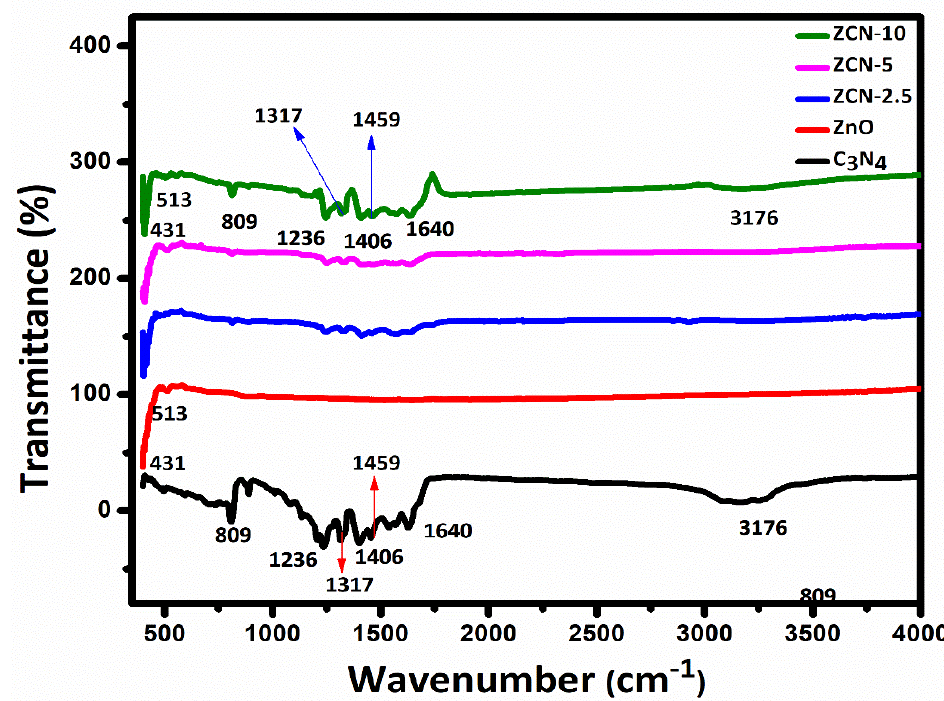
Figure 1. The FTIR spectra of ZnO, C 3 N 4 , and composites of ZnO/C 3 N 4 . As shown in Figure 2, ZnO showed various diffraction peaks at 31.7°, 34.3°, 36.3°, 47.8°, 56.6°, 62.7°, 68.3°, and 69.3°, corresponding to (100), (002), (101), (102), (110), (103), (200), and (112) lattice planes of ZnO (JCPDS file: 36-1451), indicating that the ZIF-8 was oxidized to ZnO with high purity during the calcination process. The peaks at 12.9° and 27.6° in the XRD patterns, corresponding to (100) and (002) lattice planes, confirmed the presence of C 3 N 4 . (JCPDSF No. 87-1526). No diffraction peaks of C 3 N 4 were observed in ZnO/C 3 N 4 composites because of the small amount of C 3 N 4 [33,76].